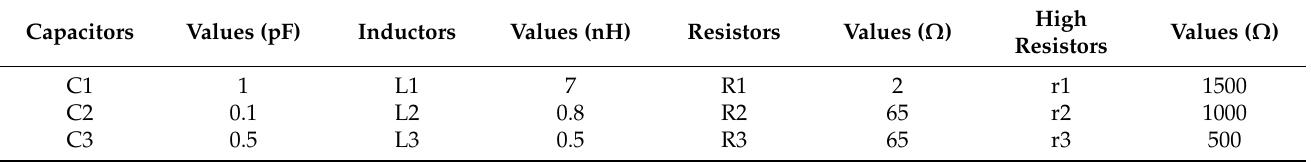
Figure 6. ( a ) Equivalent circuit model, and ( b ) reflection coefficient of the equivalent circuit model. Table 3. Values of the components used in the circuit